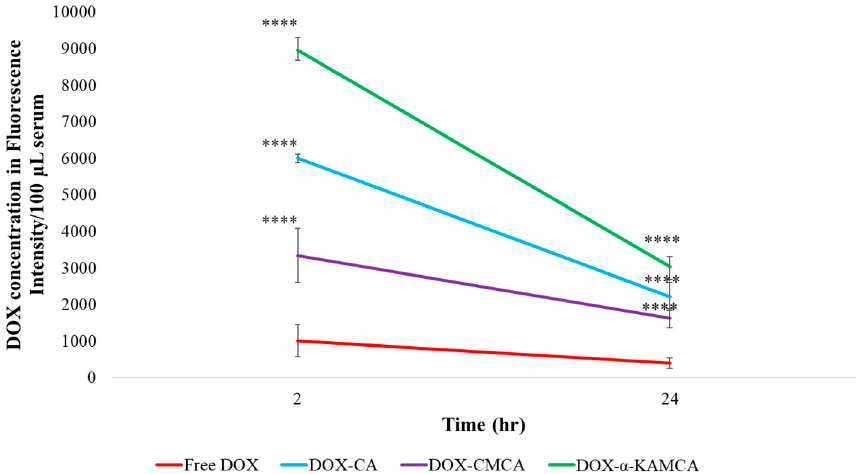
Figure 6. Experimental schema of the circulation time of DOX-loaded CA NPs, CMCA NPs, and α -KAMCA NPs compared to free DOX following an intravenous injection. Values were extremely significant (****) at a p -value < 0.0001 vs. the same treatment with free DOX at a CI of 95%.